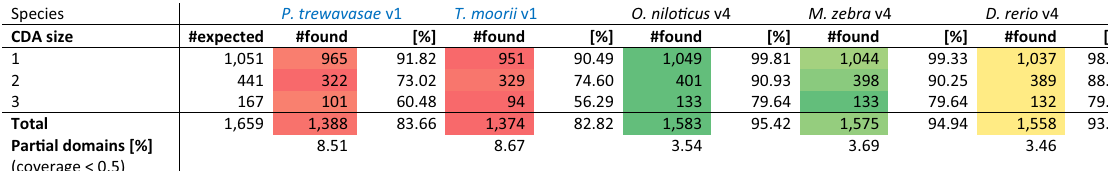
Table 7. DOGMA results: DOGMA 36 scores a sample transcriptome/proteome regarding its completeness of conserved protein domains provided as percentage of a defined core set (conserved domains are structural and functional building blocks of proteins). The analysis supports the notion (see mean and median protein lengths in Table 2) that gene models of protein-coding genes need improvement. Values are color coded according to the rank: Dark green, best; dark red, worst. CDA stands for conserved domain